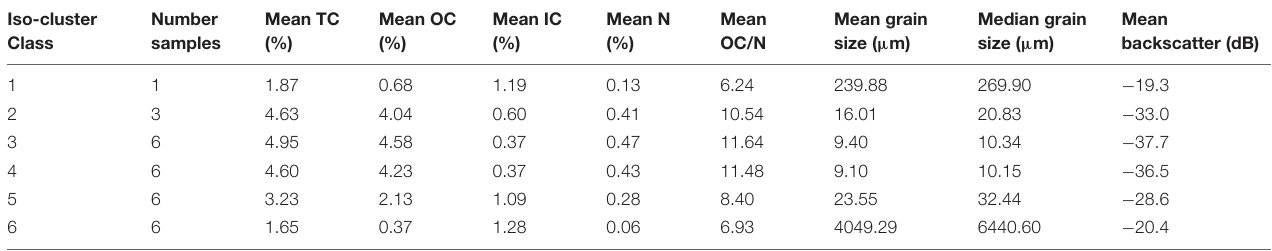
TABLE 2 | Summary of elemental and physical properties for each class from Loch Creran derived by averaging the results from all grab samples within each class. Iso-cluster Class